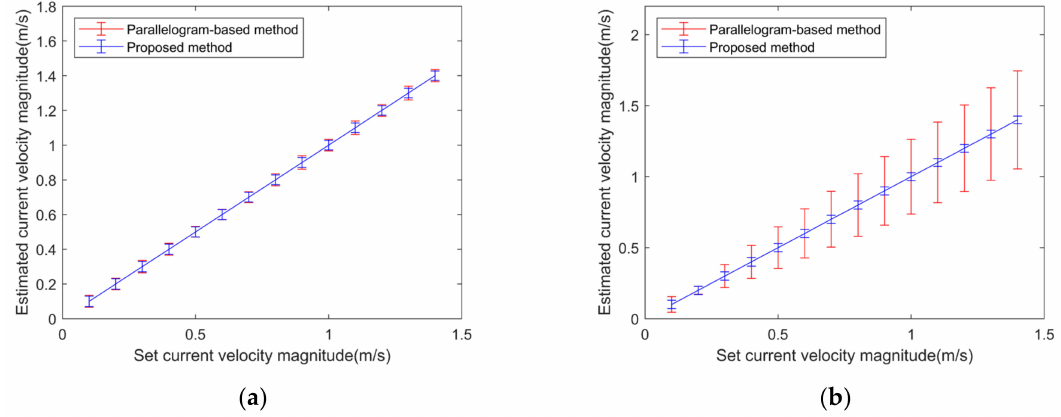
Figure 7. Error bar graphs of derived velocity magnitude using different vector determination methods. ( a ) β = 90 ◦ ( b ) β (cid:54) = 90 ◦ .